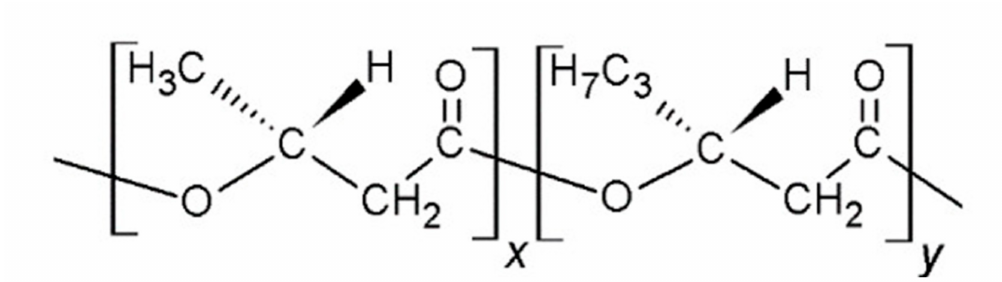
Scheme 1. Chemical structure of poly(3-hydroxybutyrate- co -3-hydroxyhexanoate) (PHBHHx). “x” and “y” represent the molar fraction of hydroxybutyrate and hydroxyhexanoate units,